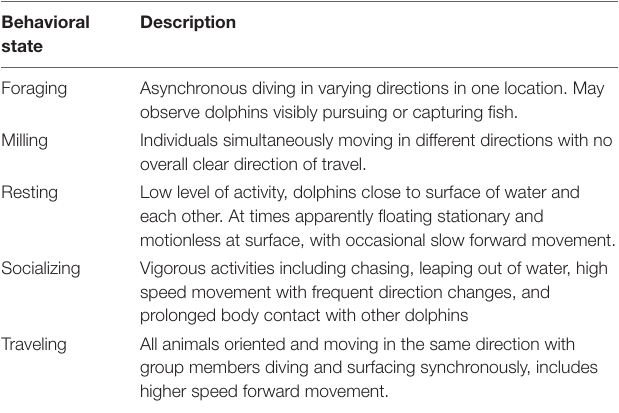
TABLE 2 | Indo-Pacific humpback dolphin behavioral activity state